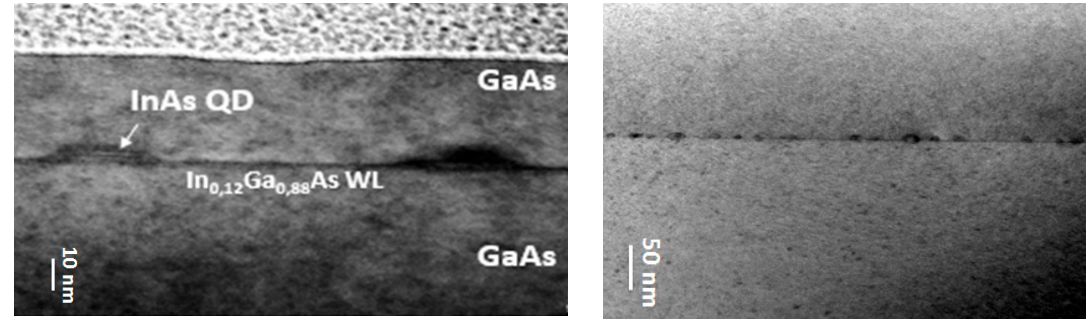
Figure 4. Cross-sectional TEM images of InAs / GaAs quantum dots grown on Ge / Si 300 mm Figure 4. Cross ‐ sectional TEM images of InAs/GaAs quantum dots grown on Ge/Si 300 mm quasi ‐ quasi-nominal nominal substrates.